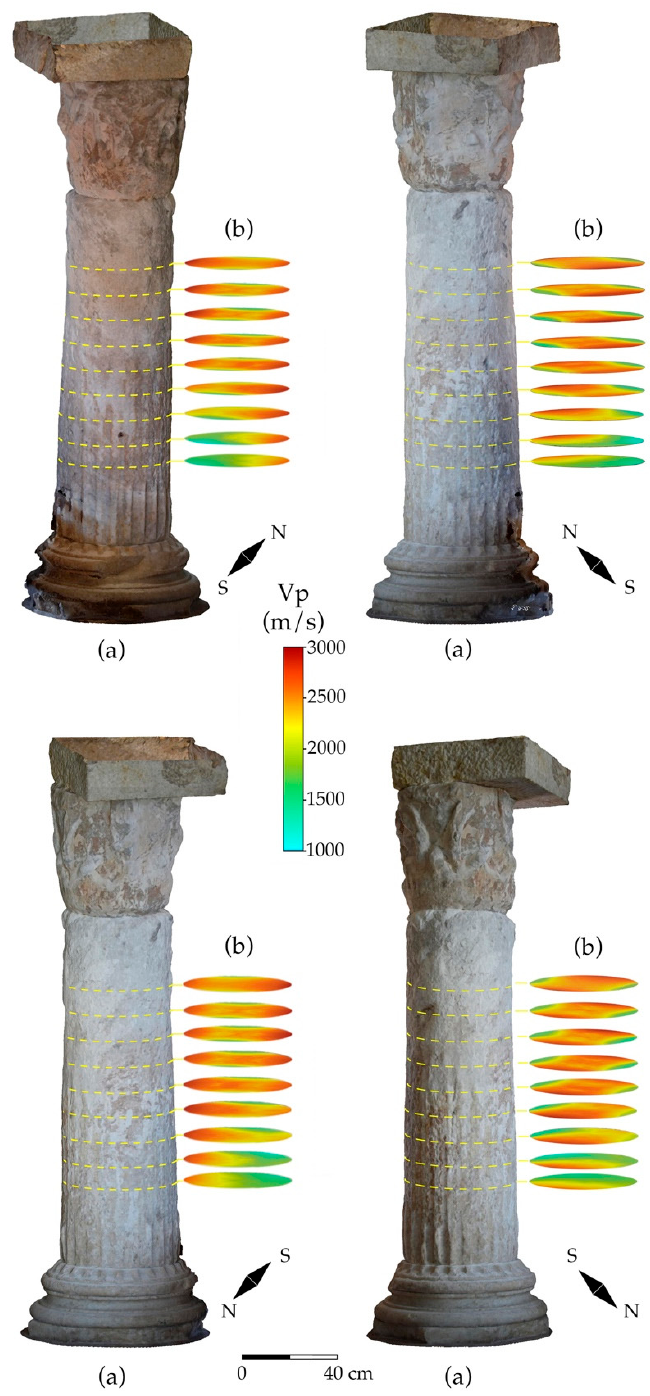
Figure 8. Different views of the tomographic slices. ( a ) CRP model; ( b ) tomographic slices.